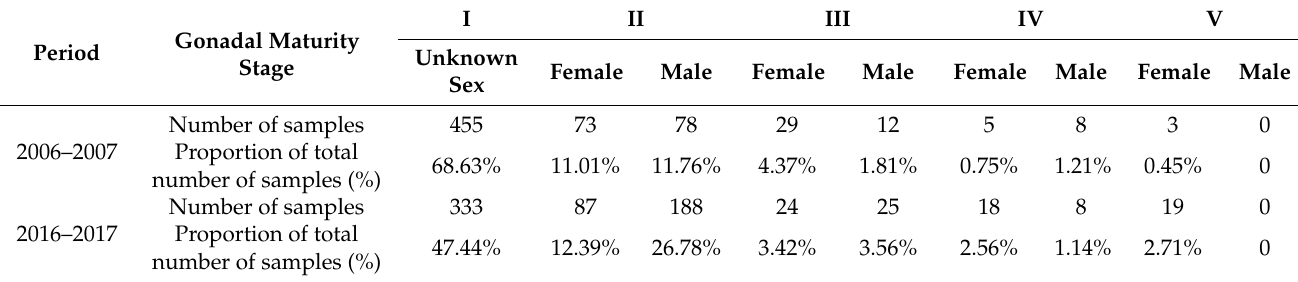
Table 3. Different stages of gonad maturation with the average body length and average body